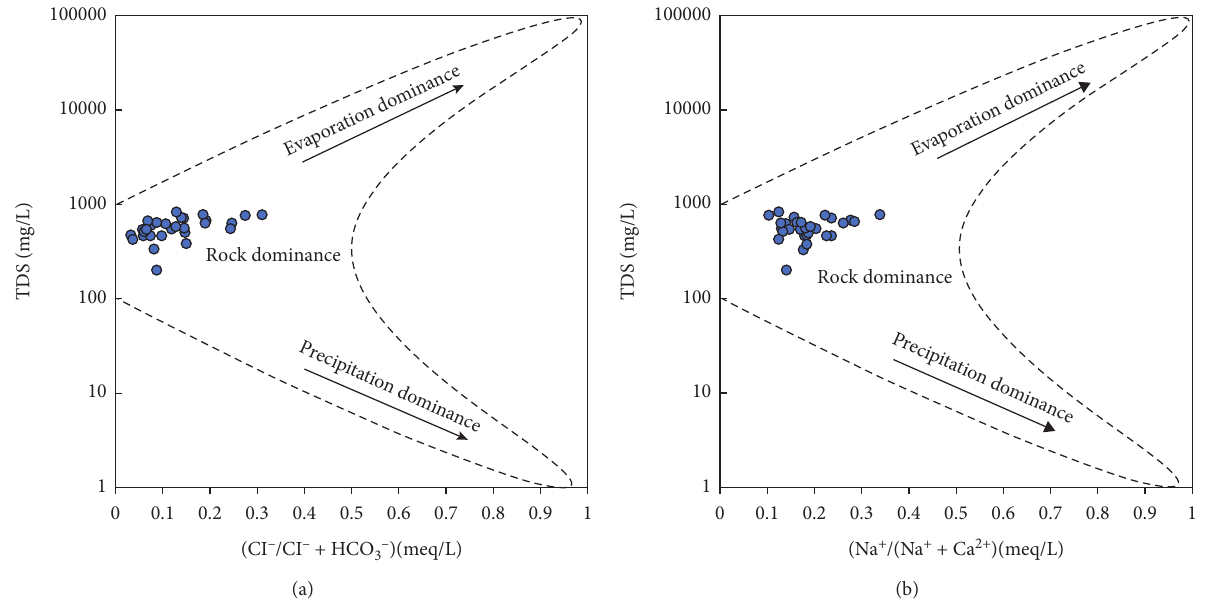
Figure 5: Gibbs diagrams demonstrating the mechanisms governing groundwater chemistry. (a) TDS vs. Cl − /(Cl − +HCO Na + /(Na + +Ca 2+